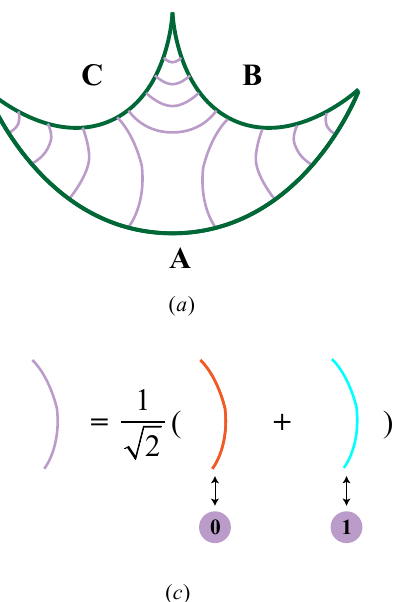
Figure 5 . (a) A locking bit thread configuration can automatically generate the SS states of a set of RT surfaces (green lines). (b) If we measure surface A to be in the state | A = 0 i , then all bit threads passing through surface A are accordingly in red state. (c) Thread/state correspondence. Each bit thread has two possible orthogonal states, represented by red lines and blue lines respectively. While the mauve lines represent the bit threads in the quantum superposition